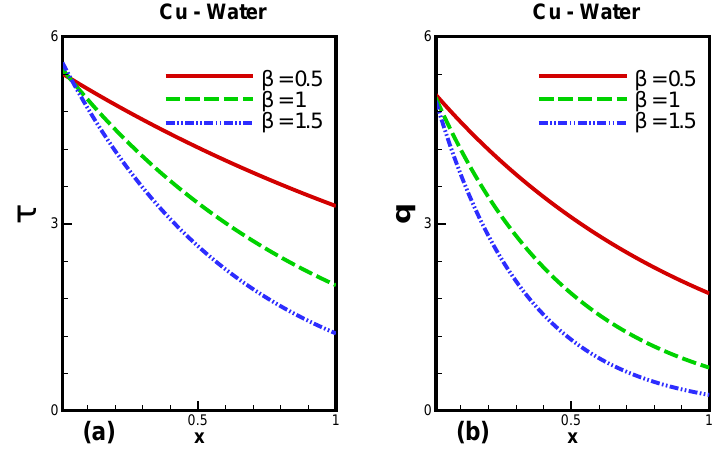
Figure 11. Effect of β on dimensionless on dimensionless ( a ) wall shear stress and ( b ) heat transfer rate, when φ = 0.05, R e = 1, δ = 0.2, B r = 6, P e = 1, and γ = 0.2.